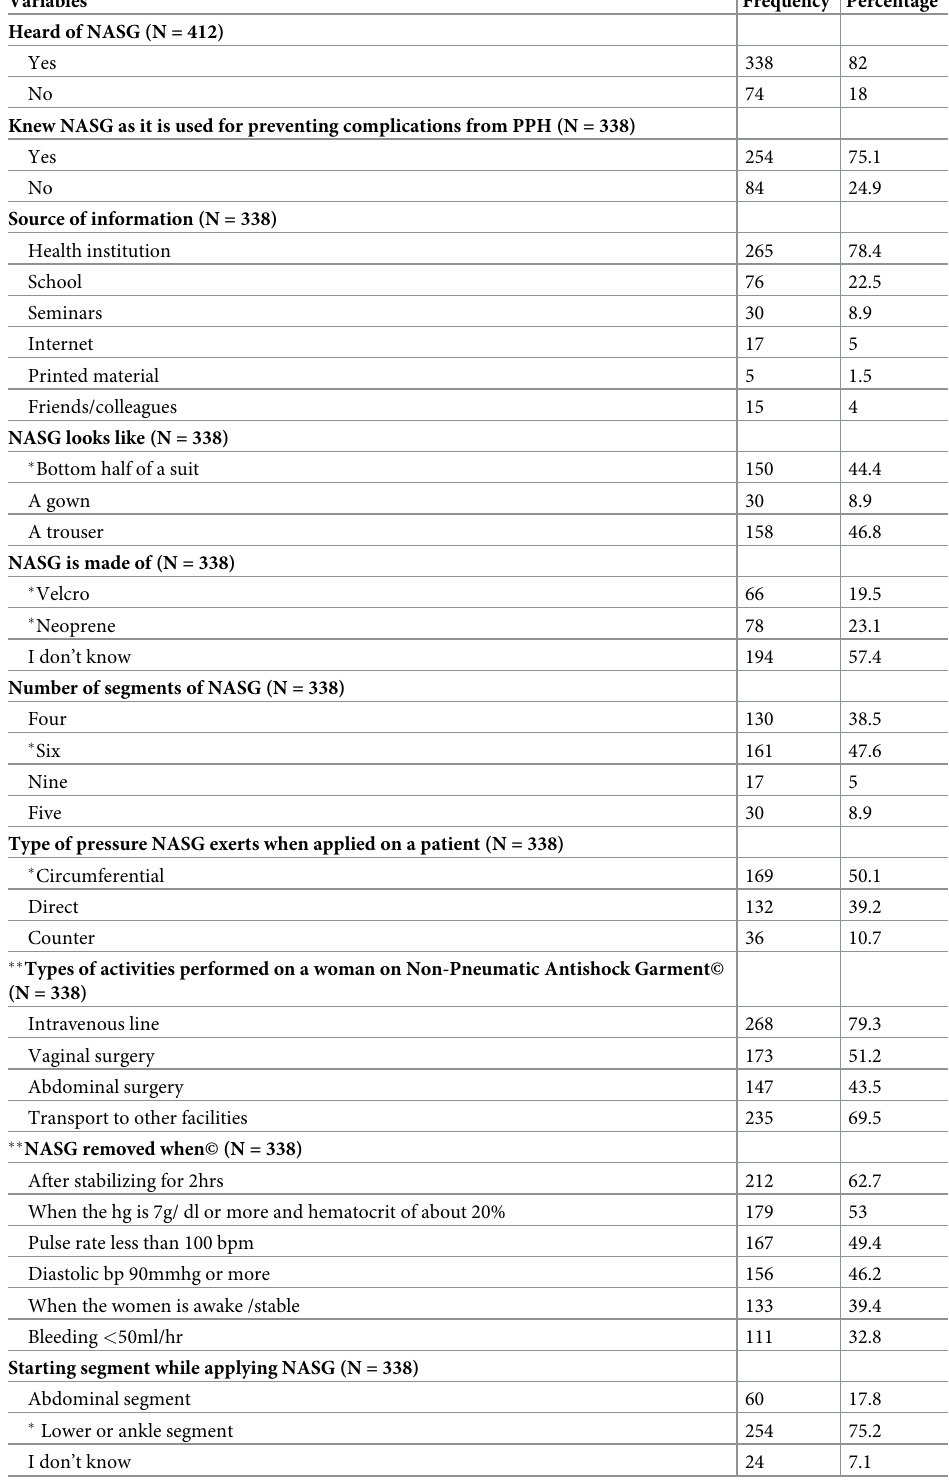
Table 3. Knowledge of NASG among obstetric care providers in public health facilities of southern Ethiopia,